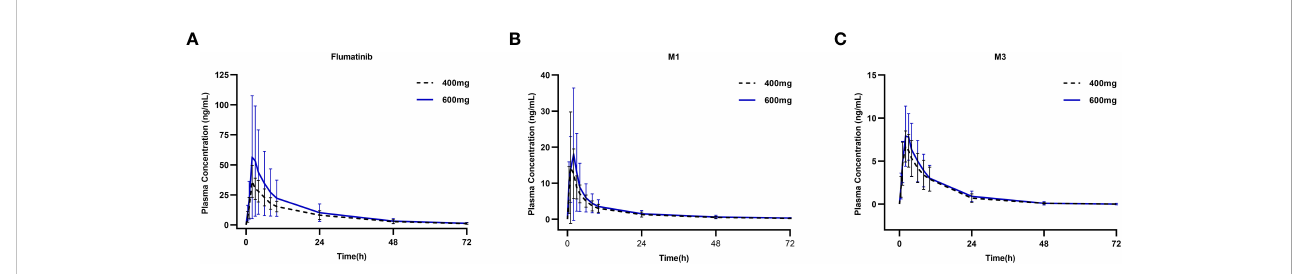
FIGURE 1 Mean plasma concentrations of fl umatinib (A) , M1 (B) and M3 (C) on day 1 after oral administration of a single-dose of fl umatinib 400 mg and 600